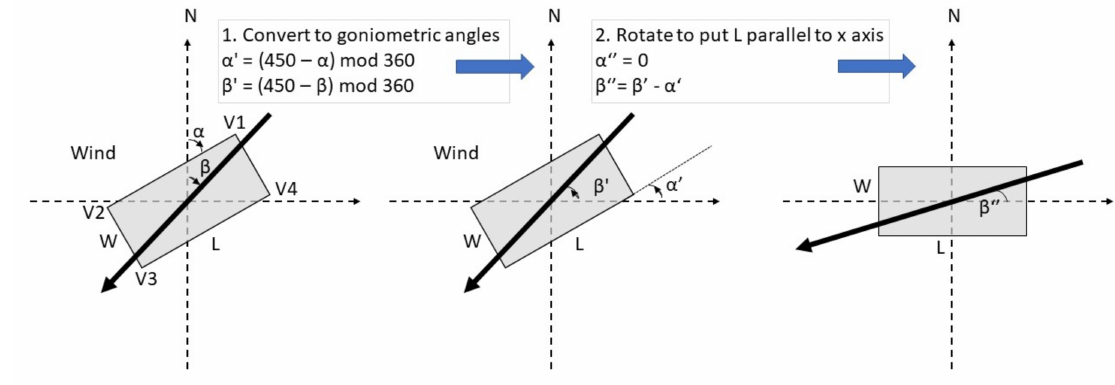
Figure 4. Path calculation when wind crosses the shortest size of the tank (W).